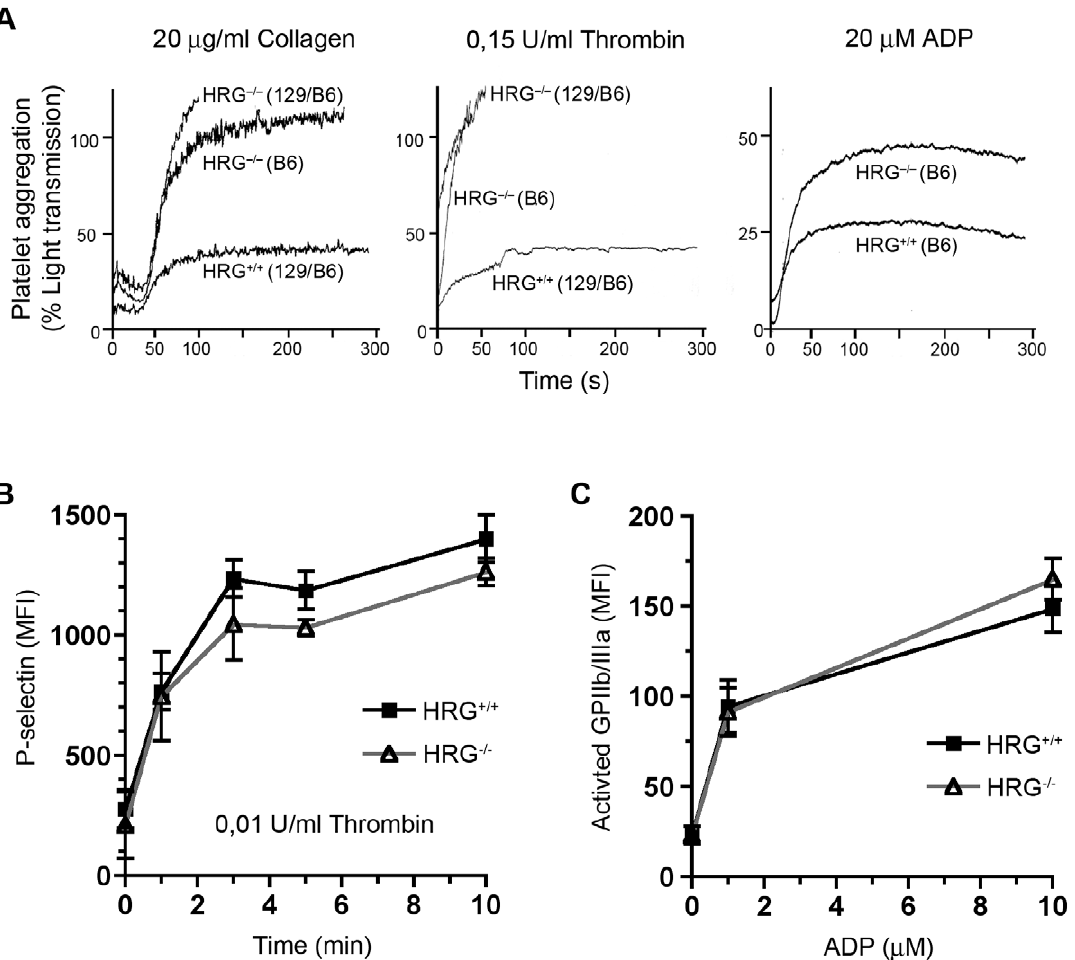
Figure 4. Enhanced aggregation of platelets in HRG 2 / 2 mice. (A) Collagen, thrombin and ADP-induced platelet aggregation in PRP from HRG + / + and HRG 2 / 2 mice on a pure C57BL/6 (B6) or on a mixed 129/Ola, C57BL/6 (129/B6) genetic background was measured with an aggregometry assay. Aggregation levels are represented by light transmission through PRP over time. (B–C) Flow cytometric analyses of thrombin- and ADP- induced activation of platelets presented by mean fluorescent intensity (MFI). Ligands were added at time=0. Each symbol (squares=HRG + / + , open triangles=HRG 2 / 2 ) represents the mean value from three independent measurements. Vertical bars represent standard deviation. (B) P-selectin after activation with 0,01 U/ml thrombin measured at 0, 1, 3, 5 and 10 minutes. (C) Activated fibrinogen receptor (GPIIb/IIIa) after 15 minutes stimulation with 1 or 10 m M ADP.